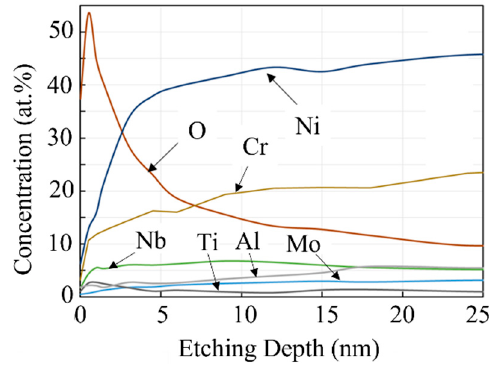
Figure 8. XPS depth profiles of virgin Inconel 718 PA powder.